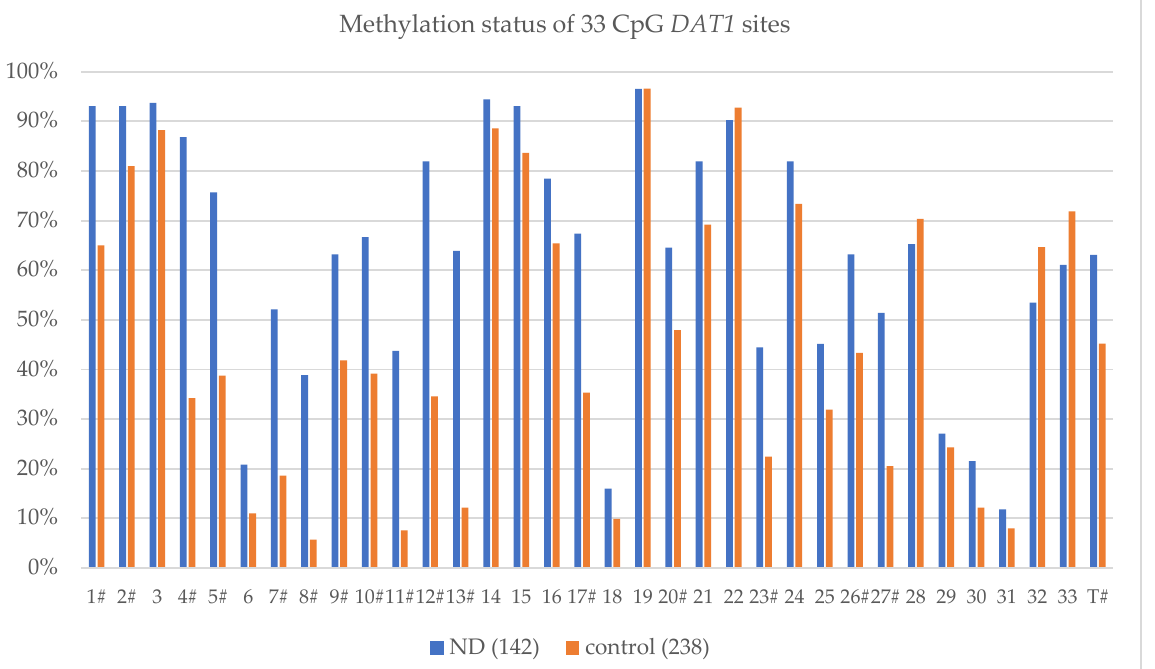
Figure 1. The methylation level (%) of 33 CpG DAT1 sites in a group of nicotine-dependent subjects (ND) and controls. # statistically significant differences in the level of methylation-Bonferroni correction was used, and the p -value was reduced to 0.0015 ( p = 0.05/33 (number of statistical tests conducted)). T—% Total methylation sites. r = 0.273; p = 0.001 Between the total methylation sites (M T% ) of 33 CpG DAT1 sites and the number of cigarettes smoked in a group of nicotine-dependent subjects, the Pearson’s Correlation was positive (r = 0.273, p = 0.001, Figure 2).